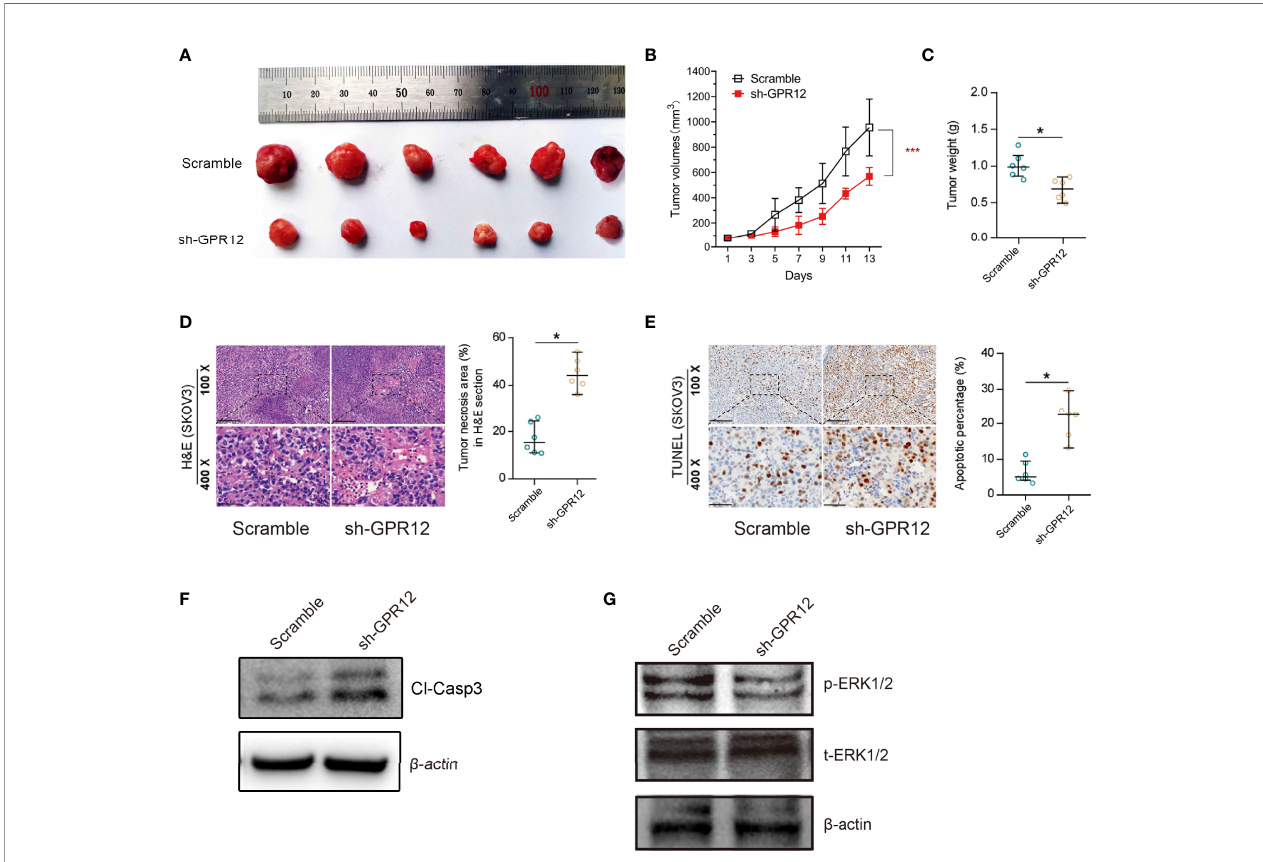
FIGURE 4 | GPR12 knockdown inhibits tumor growth of EOC cells in vivo . (A) Representative images of the SKOV3 cancer cell tumor xenograft from each mouse (n = 6 mice per group). (B) Tumor growth in xenograft mice was recorded. (C) The weight of tumors was measured. (D) HE staining on the xenograft tumors. Scale bar = 100 m m in the upper panels and 20 m m in the below panels. (E) The apoptosis was analyzed by TUNEL staining. Scale bar = 100 m m in the upper panels and 20 m m in the below panels. (F) Protein expression of cleaved caspase3 was determined by Western blot in the tumor tissues from the xenograft mice. (G) Protein expression of p-ERK1/2 and t-ERK1/2 was determined in the tumor tissues from the xenograft